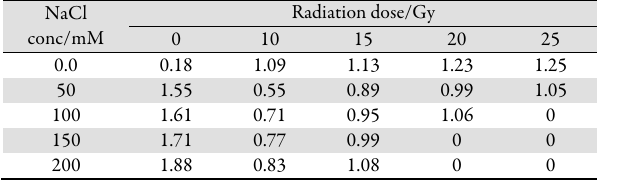
Table 2. The combined effects of gamma radiation doses and NaCl concentrations on proline contents (mg/100 gm fresh wt.) in haploid Nicotiana alata plants